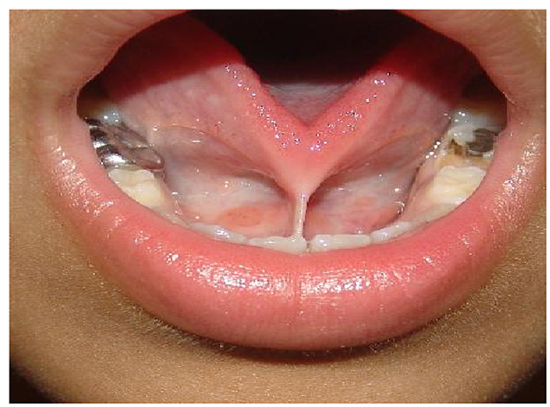
Figure 1: A photographic picture of ankyloglossia ( or tongue - tie ) from Zahra ’ s text.